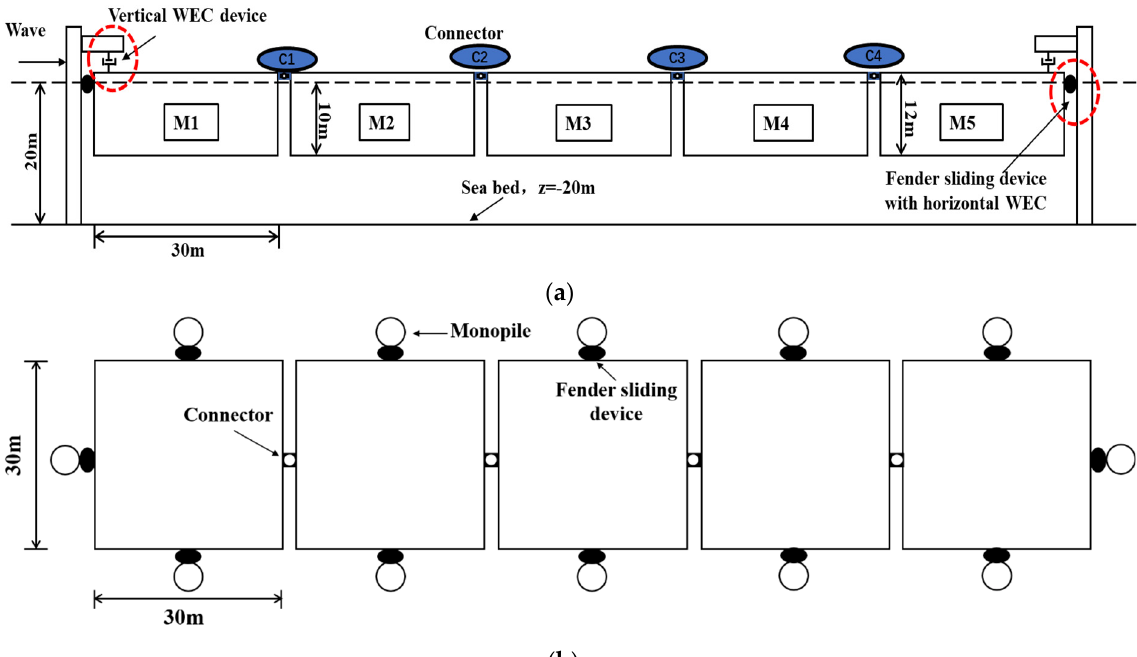
Figure 1. Conceptual sketch of the MIFS with DFM: ( a ) side view; and ( b ) top view.